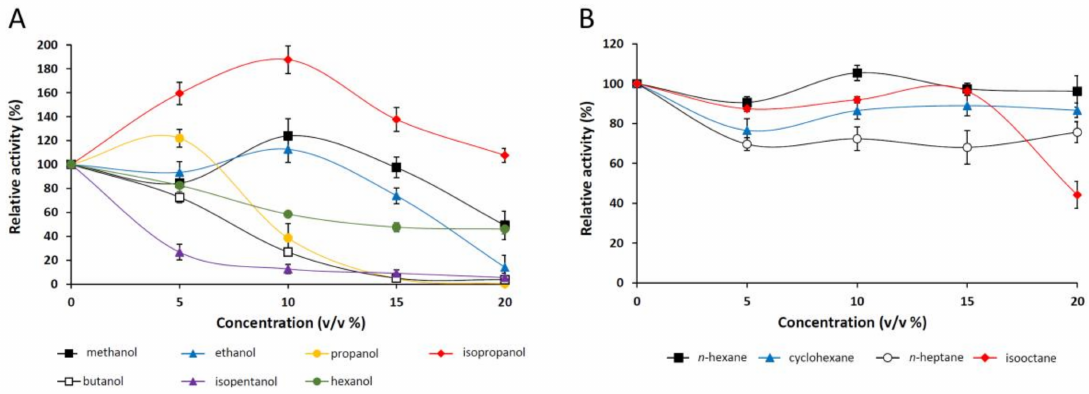
Figure 5. Stability of M. echinosphaera CBS 575.75 lipase in the presence of various alcohols ( A ) and alkanes ( B ). The p NPP-hydrolyzing activity was determined after 30-min preincubation of the purified enzyme at 25 ◦ C in phosphate buffer (pH 6.8) containing the corresponding solvent (5–20%, v / v ). The activity measured without any solvents was taken to be 100%. Values are means ( n = 3); error bars indicate standard